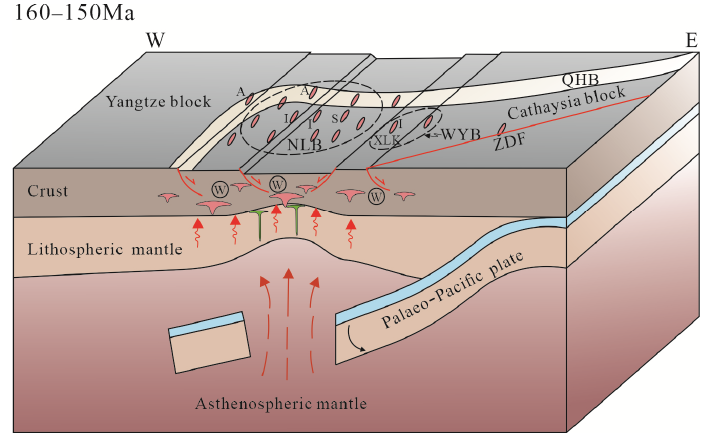
Figure 7. Cartoon showing the geodynamic setting of W mineralization in south China (modified after [78]).